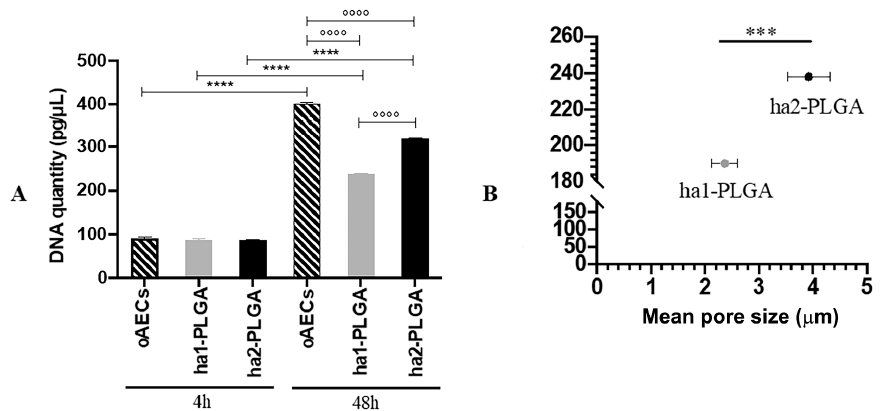
Figure 5. Cell seeding e ffi ciency and the e ff ect of fiber diameter size on oAECs’ proliferation. Cells were seeded on Petri dishes (oAECs) or ha1-PLGA and ha2-PLGA electrospun fleeces and allowed to grow for up to 48 h. ( A ) DNA quantification by Qubit ® dsDNA HS Assay on oAECs on Petri dishes or seeded fleeces after 4 h and 48 h of culture to verify cell adhesion, seeding e ffi ciency, and to assess DNA quantity. It is shown that there is a higher proliferation rate in the case of ha2-PLGA compared to ha1-PLGA after 48 h of culture. *** and **** Statistically significant in the same sample type at di ff erent ◦◦◦◦ time points ( p < 0.001 and p < 0.0001, respectively). Statistically significant between di ff erent sample types at 48 h ( p < 0.0001) (n = 3 for each type of sample / analysis / time point, fleece size: 15 mm × 7 mm). ( B ) Comparison showing that increasing pore size of ha-PLGA fleeces is accompanied by an increase in cell proliferation rate confirmed by a significant increase of DNA quantity in ha2-PLGA compared to ha1-PLGA ( p < 0.0001) after 48 h of